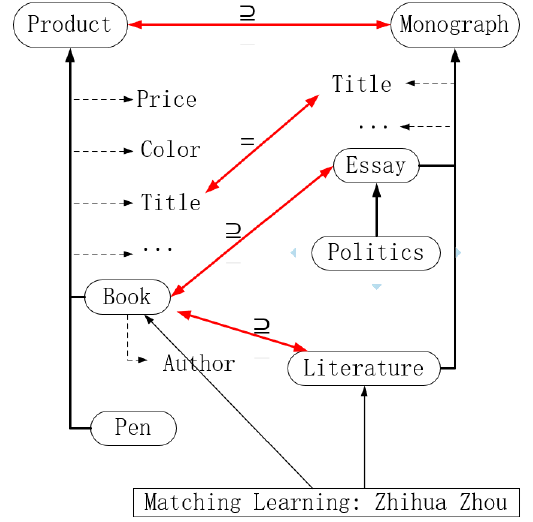
Figure 2. An Example of Two Ontologies and Their Alignment.